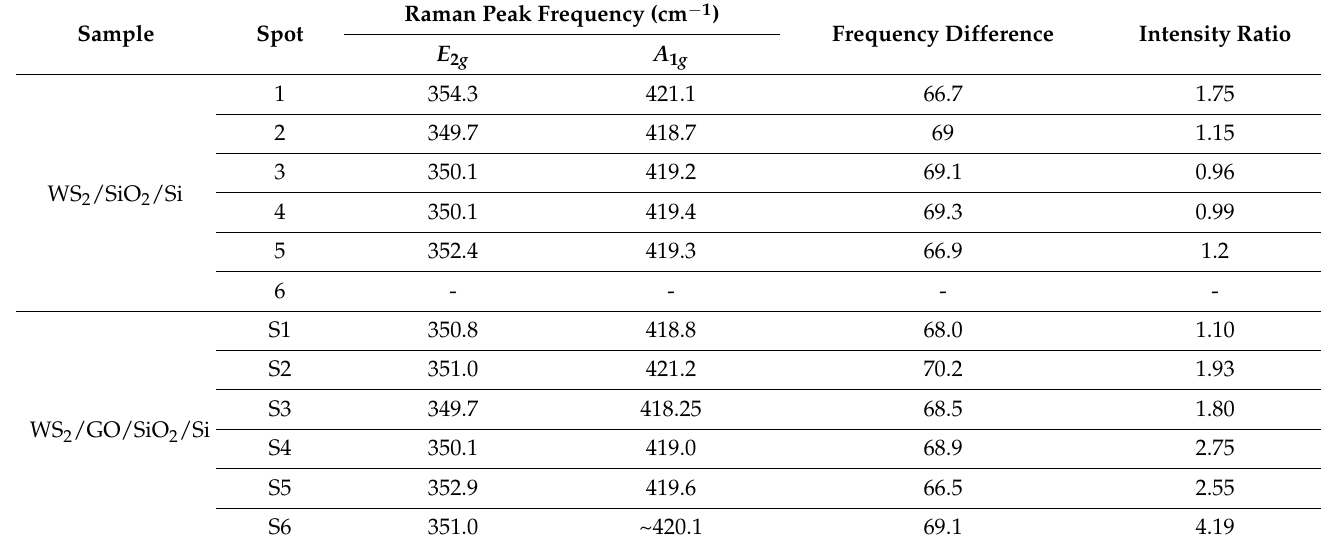
Table 1. Summary of Raman studies of WS 2 nanoflakes deposited on different spot of GO coated substrate. Sample